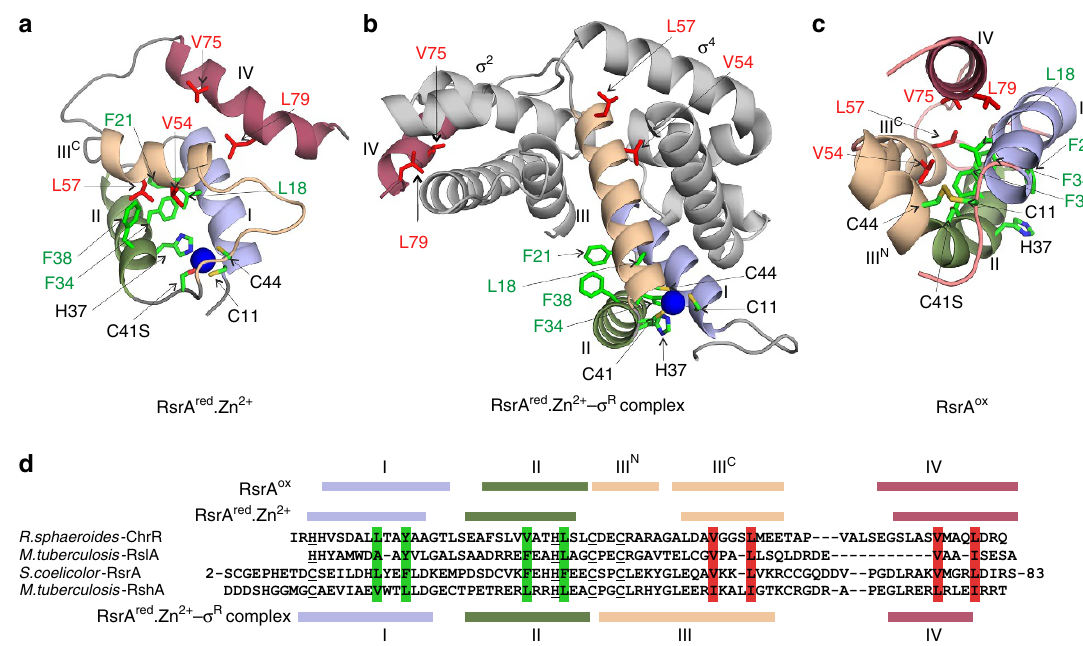
Figure 7 | RsrA red .Zn 2 þ uses hydrophobic core residues to bind r R that are sequestered to the RsrA ox interior following oxidation. ( a ) Solution structure of RsrA red .Zn 2 þ . RsrA helices are coloured N to C as in the sequence alignment in d . Zinc is shown as a blue sphere and zinc ligands coloured by atom type. Conserved or conservatively substituted hydrophobic residues that contribute to RsrA’s hydrophobic core in all three of its structural states ( a – c ) are coloured green, while those that also interact with s R are coloured red. ( b ) Homology model of the RsrA red .Zn 2 þ – s R complex validated by homo- bifunctional lysine-specific crosslinking (Supplementary Fig. 5). The structure of RsrA red .Zn 2 þ changes markedly to embrace s R . ( c ) Solution structure of RsrA ox where the trigger disulfide is formed between residues Cys11 and Cys44, expelling bound zinc and repacking the hydrophobic core. ( d ) Sequence alignment of RsrA and other ZAS proteins (ChrR, RshA and RslA). Zinc ligands in each protein are underlined. Helices in all three structural forms of RsrA are coloured as in a – c . Vertical green shading shows conserved hydrophobic residues that contribute to the hydrophobic core of RsrA in all three structural states (RsrA red .Zn 2 þ , RsrA red .Zn 2 þ – s R complex and RsrA ox ). Vertical red shading shows conserved hydrophobic residues in RsrA that contribute to the hydrophobic cores of RsrA red .Zn 2 þ and RsrA ox , but also contribute to the protein–protein interface in the RsrA red .Zn 2 þ – s R